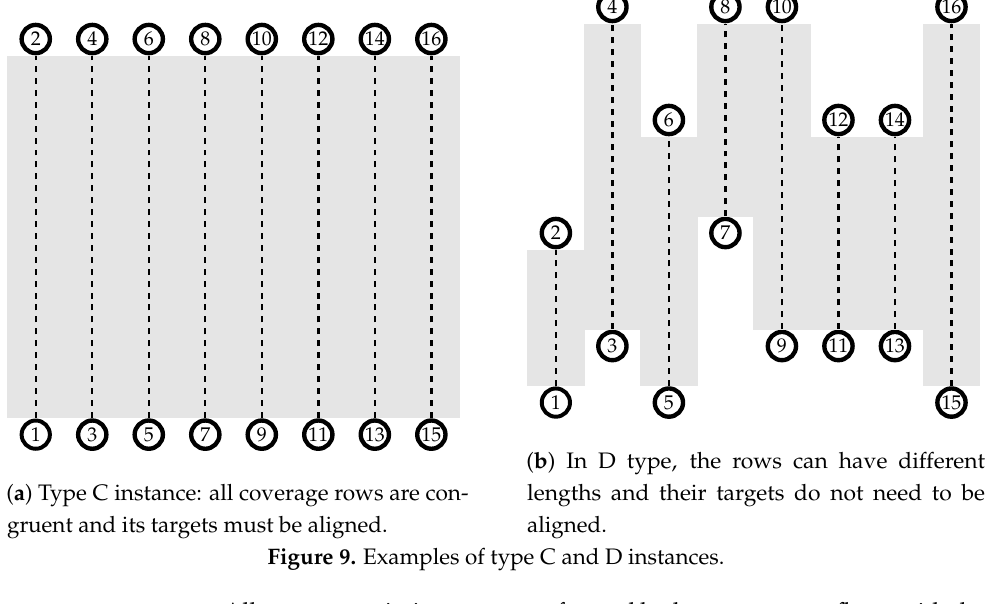
Figure 9. Examples of type C and D